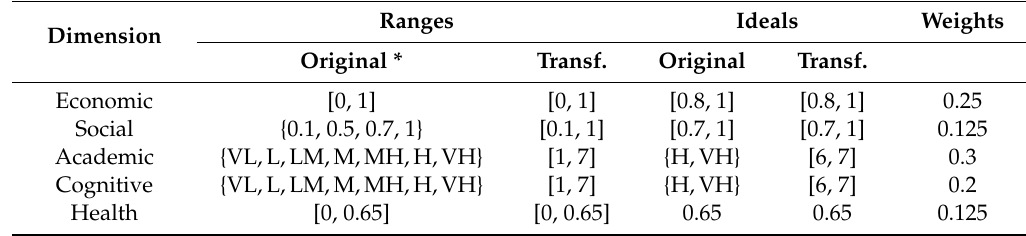
Table 3. Range, ideal, and weighting of each